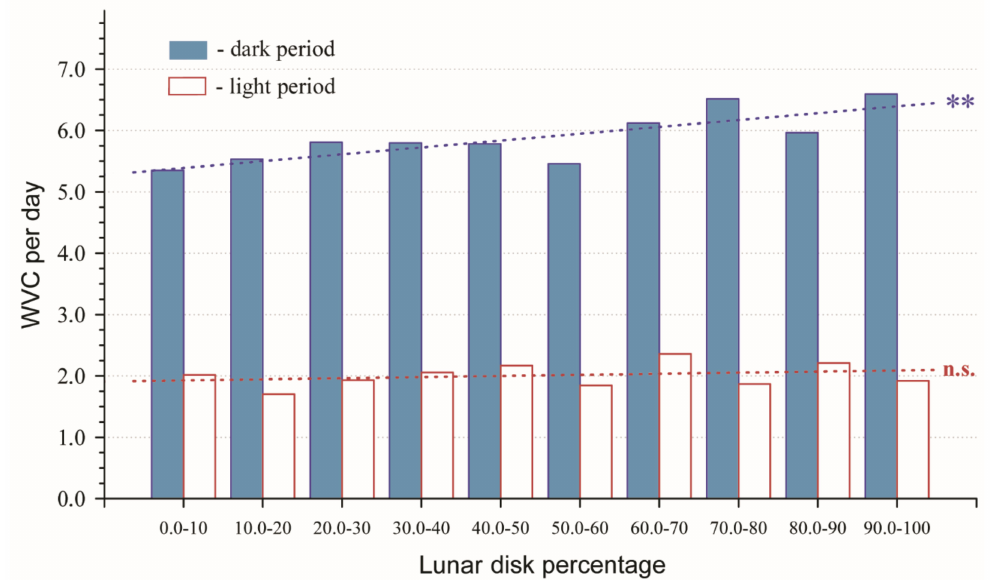
Figure 2. Average wildlife–vehicle collisions (WVCs) per day for 10% interval lunar disk percentages. Filled columns = dark period (night—sunset to sunrise); open columns = light period (day—sunrise to sunset). Asterisks indicate significant trendline (r s = 0.79; p = 0.006). n.s. = non-significant. We observed significant positive correlations between the LDP and the total daily number of WVCs during winter (December–February) (r s = 0.118; p = 0.012; n = 451) and autumn (August–November) (r s = 0.127; p = 0.007; n = 456) but no significant relationship between the LDP and the total daily number of WVCs during summer (r s = 0.089; p = 0.055; n = 461) and spring (March–May) (r s = 0.05; p = 0.288; n = 460). There were